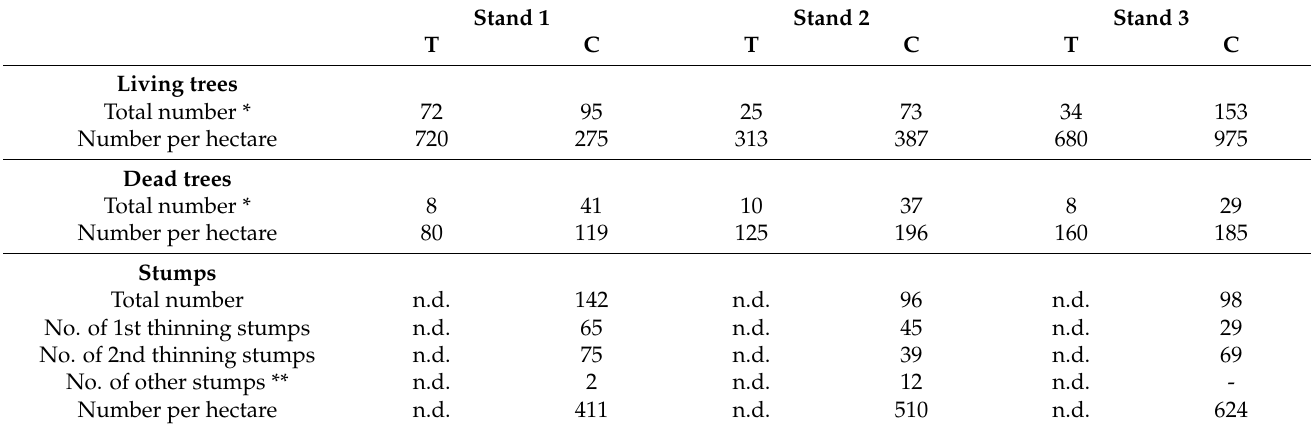
Table 2. Characteristics and dieback rate in Norway spruce stands on former pastures (Stand 1) and meadows (Stands 2 and 3). (T—transect; C—disease centres (circular sample plots). Stand 1 Stand 2 Stand 3 T C T C T C